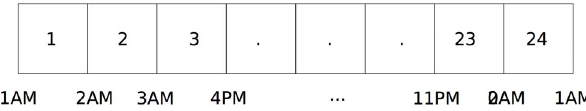
Figure 7. Hourly time frame was used to capture daily activity